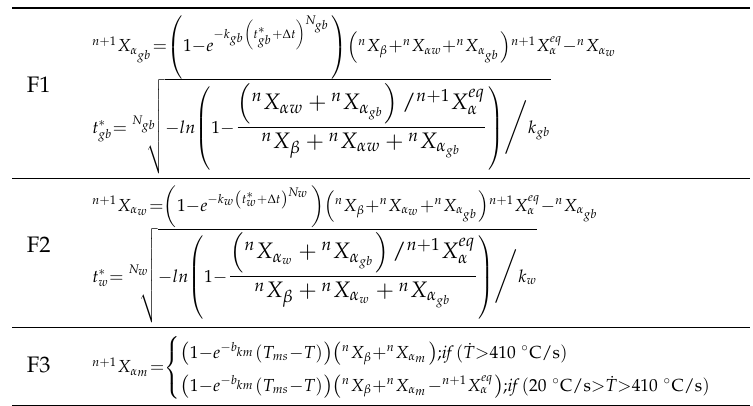
Table 1. Models for α -phase